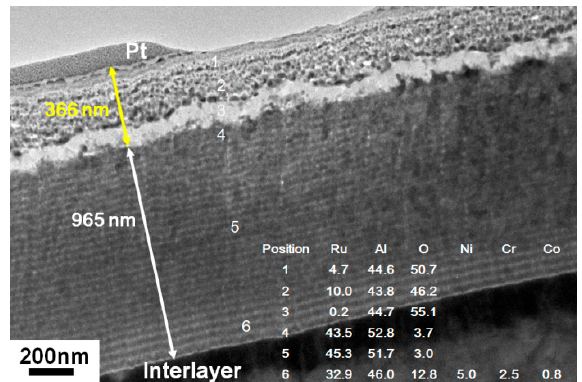
Figure 12. Cross-sectional TEM image and EDS results for the Ru 0.46 Al 0.54 /Ru/Inconel 617 sample after annealing in air at 800 °C for 30 min.